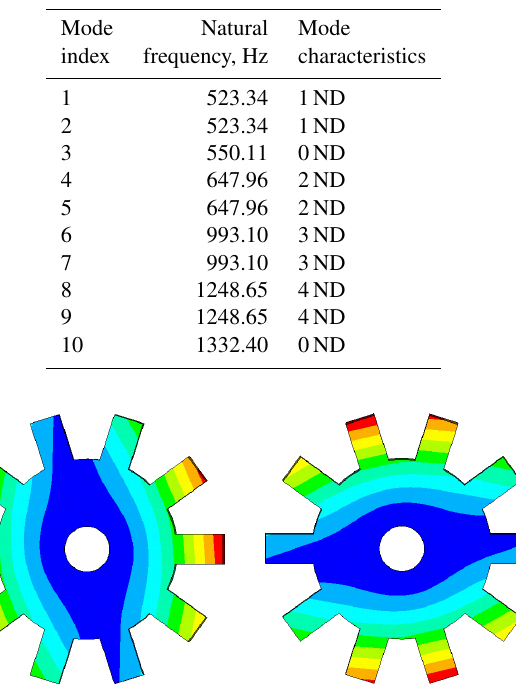
Table 2. The first 10 natural frequencies of the disk without cracks.